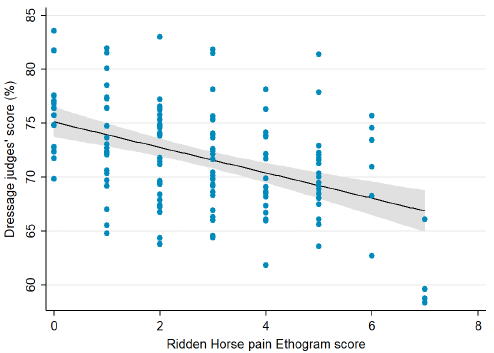
Figure 1. The relationship between the Ridden Horse Pain Ethogram score (0–24) and the dressage judges’ score (percentage) for 147 competitors at World Cup Grand Prix Dressage Western League qualifiers ( n = 7) and championships ( n = 2), showing the individual scores, fitted linear prediction and 95% confidence interval (CI). There was a moderate negative correlation (Spearman rho − 0.3956, p < 0.001). Note the y-axis does not start at zero.